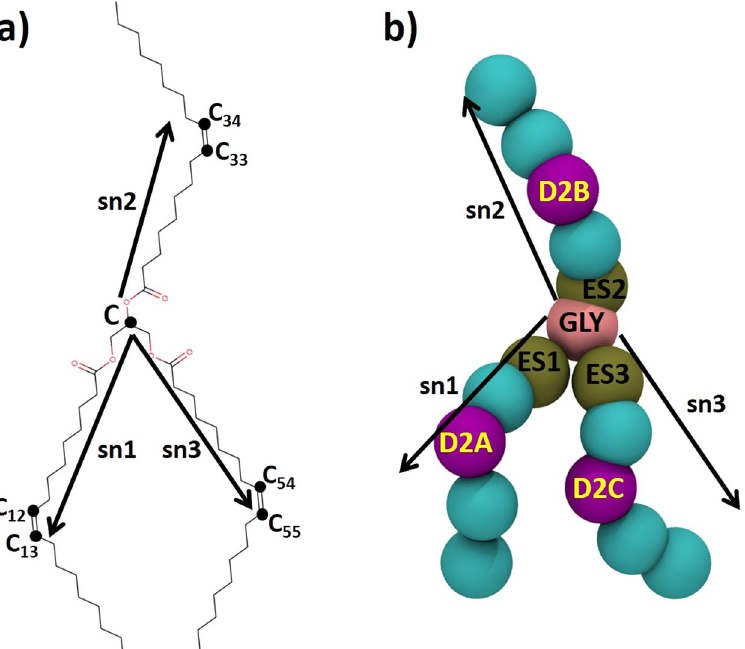
Figure 1. ( a ) Molecular structure of a triolein molecule (TG). Three vectors - sn1, sn2, sn3 are defined on the molecular frame of TG to describe its different conformations. ( b ) Coarse grained representation of TG. Central glycerol bead is shown in rose color, carboxyl moiety-containing beads are shown in ochre, oleoyl apolar moieties are shown in cyan, and the unsaturated moieties are shown in pink